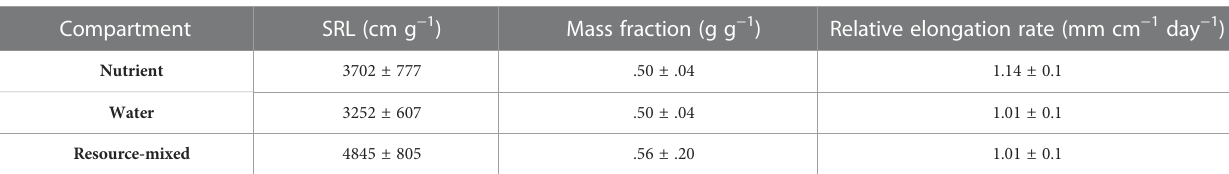
TABLE 2 Speci fi c root length (SRL), mass fraction of root biomass, and relative root elongation rates of P. virgatum present in three compartment types (mean ±